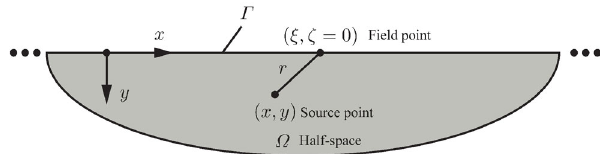
Fig. 1 Schematic representation of a